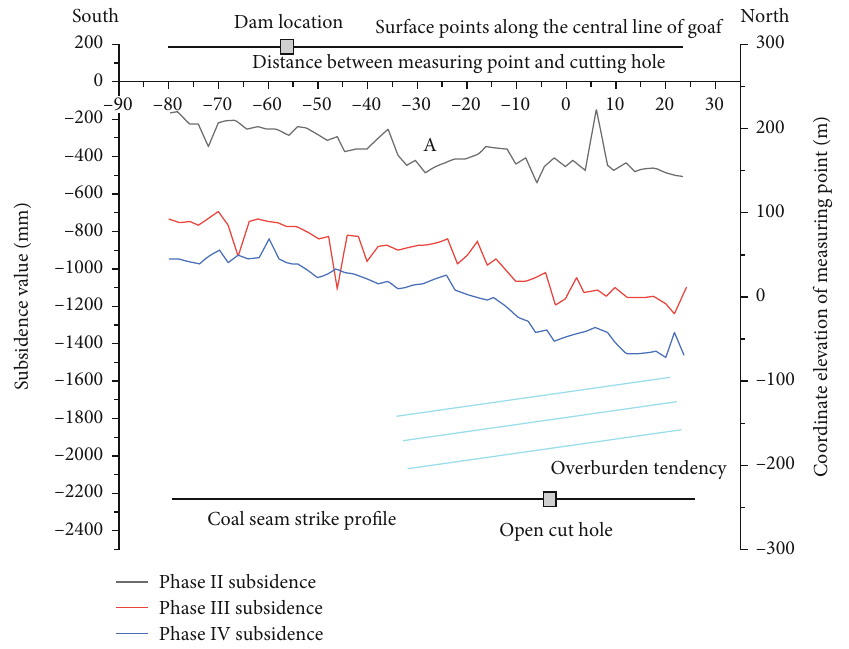
Figure 19: The subsidence in decline direction along the midline of the mining